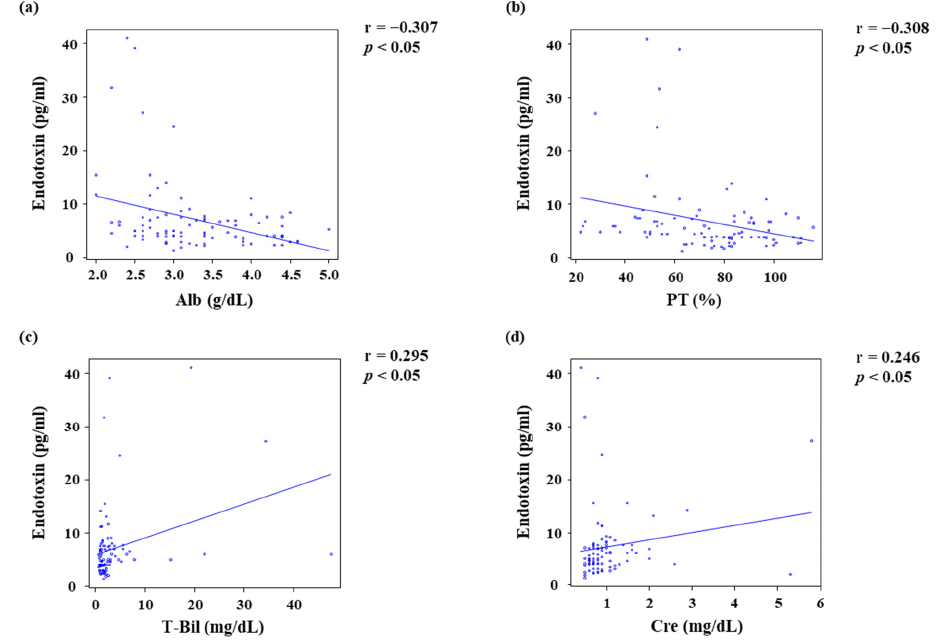
Figure 5. Relationship between endotoxin levels and patient characteristics. ( a , b ) Endotoxin levels were inversely correlated with Alb (r = − 0.307, p < 0.05) and PT (r = − 0.308, p < 0.05). ( c , d ) Endotoxin levels were directly correlated with T-Bil (r = 0.295, p < 0.05) and Cre (r = 0.246, p < 0.05). Alb, albumin; PT, prothrombin time; T-Bil, total bilirubin; Cre, creatinine.